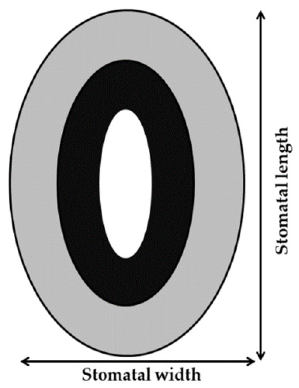
Figure 1. Schematic representation of the stomatal dimensions as measured by image analysis. The grey area represents the guard cells, the black area the pore walls, and the white area (internal ellipse) depicts the stomatal pore area.